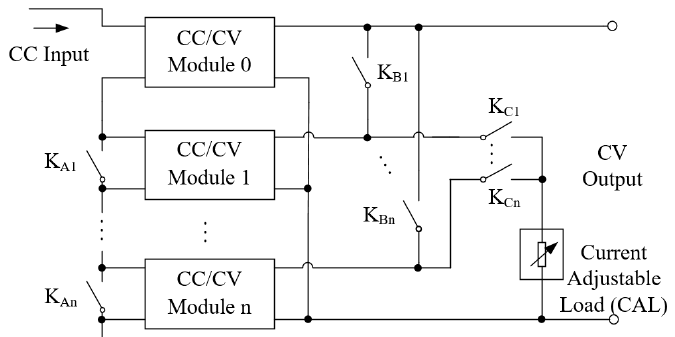
Figure 4. The schematic block of the multi-module-stack structure based on the ASB (active soft bypass) and PPMS (priority-based power management strategy).